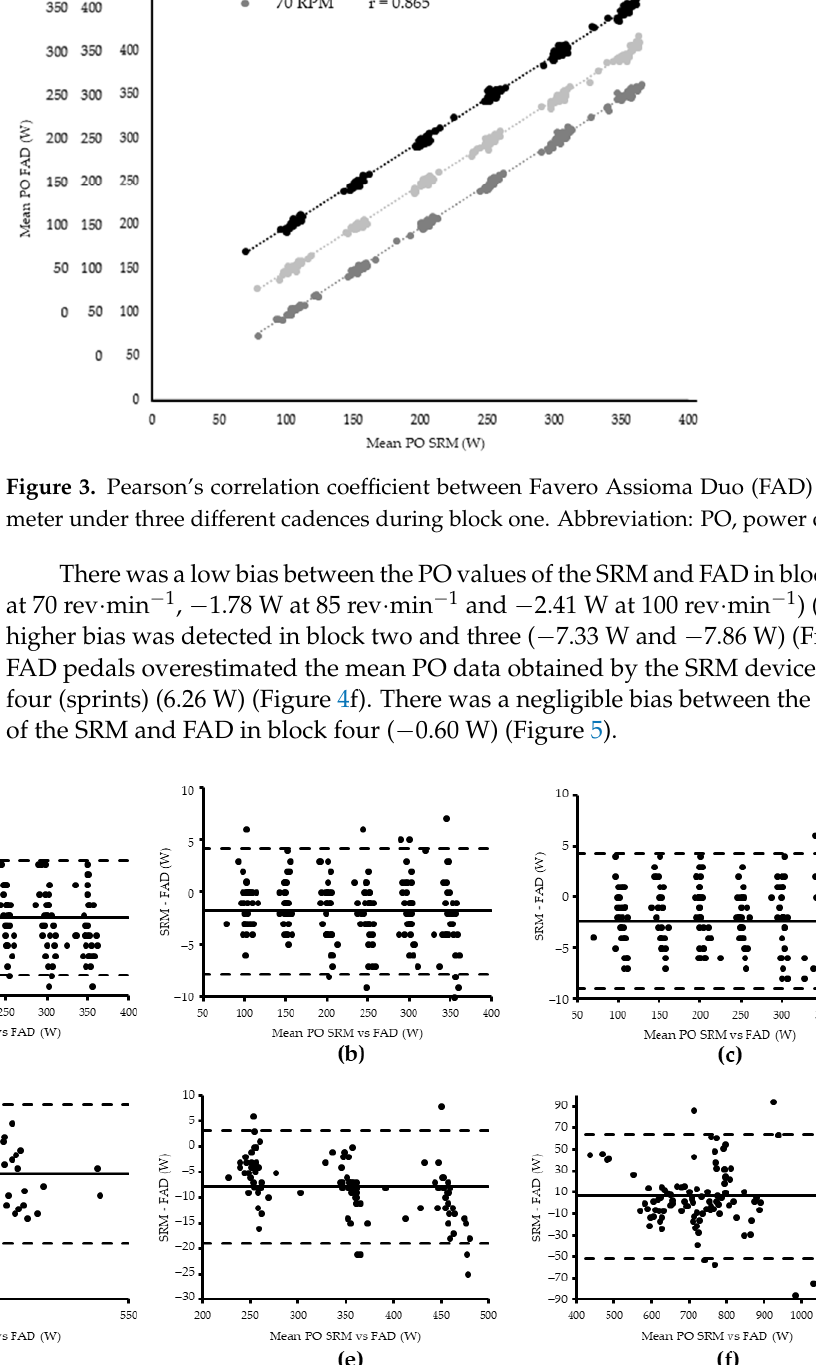
Figure 4. Bland–Altman plot representing the agreement between SRM and FAD mean power output (PO) for block one ( a – c ), two ( d ), three ( e ), and four ( f ).